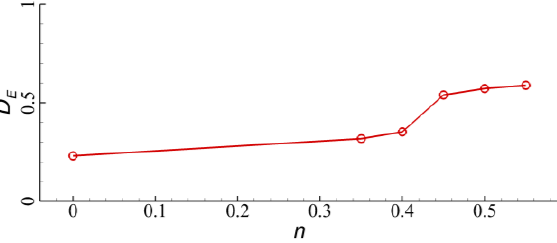
Figure 22. Variations in the total wave energy dissipation rate of the focused wave groups with the porosity.